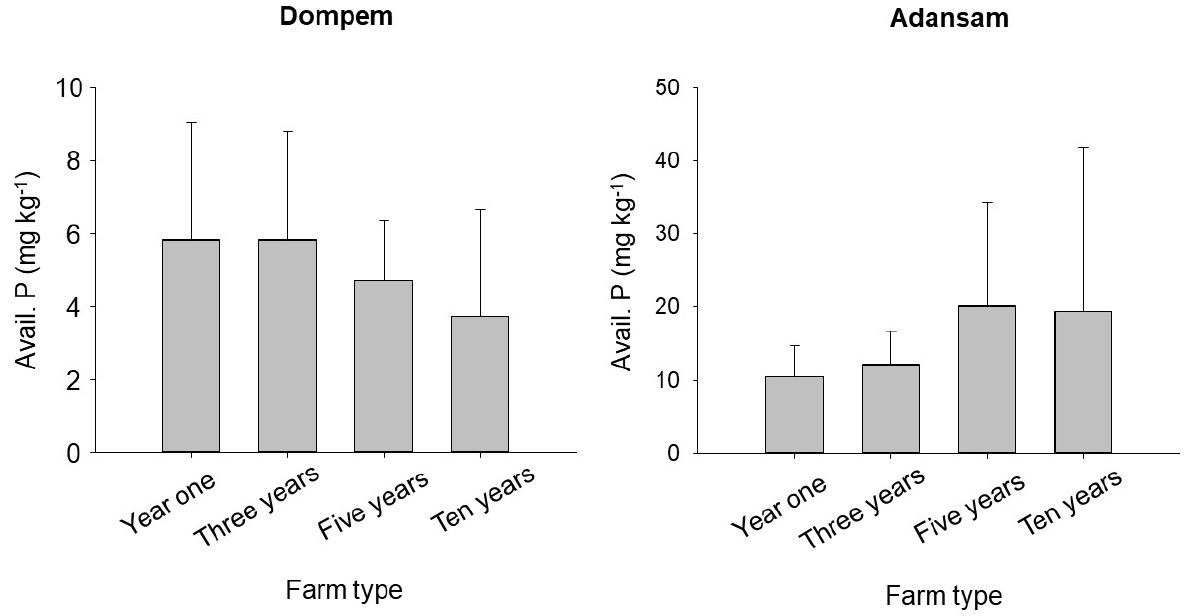
Figure 4. Available P contents in soils of Dompem ( p > 0.05; n = 9 ± one standard deviation) and Adansam ( p > 0.05; n = 11 ± one standard deviation).